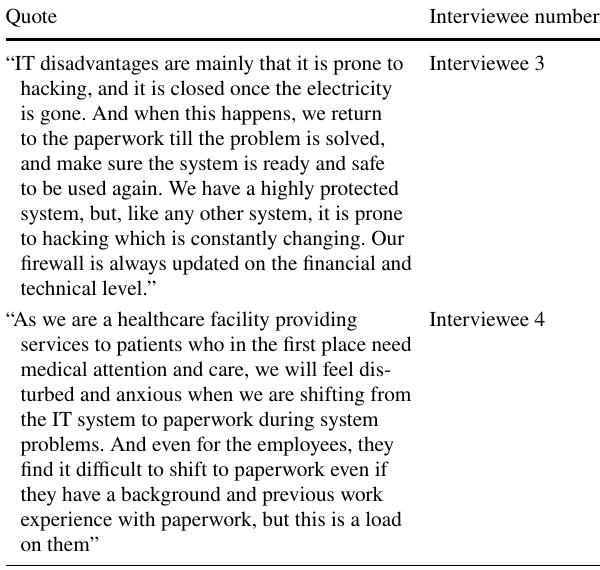
Table 4 Negative effects of IT on healthcare due to electricity